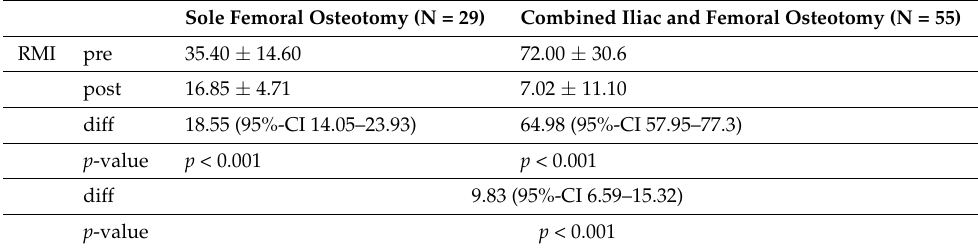
Figure 2. ( left ) Anteroposterior radiograph of a nine-year-old male with LCPD; ( right ): result three months postoperatively. Table 4. Improvement of RMI with and without osteotomy of the